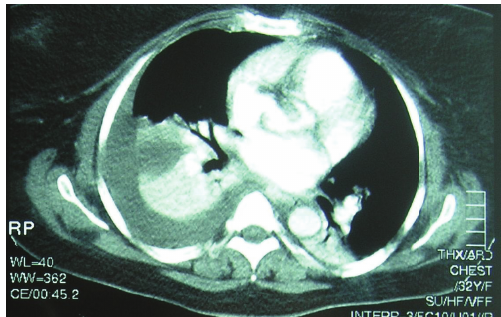
Figure 3: Case 2: CT scan revealing ipsilateral pleural e ff usion.